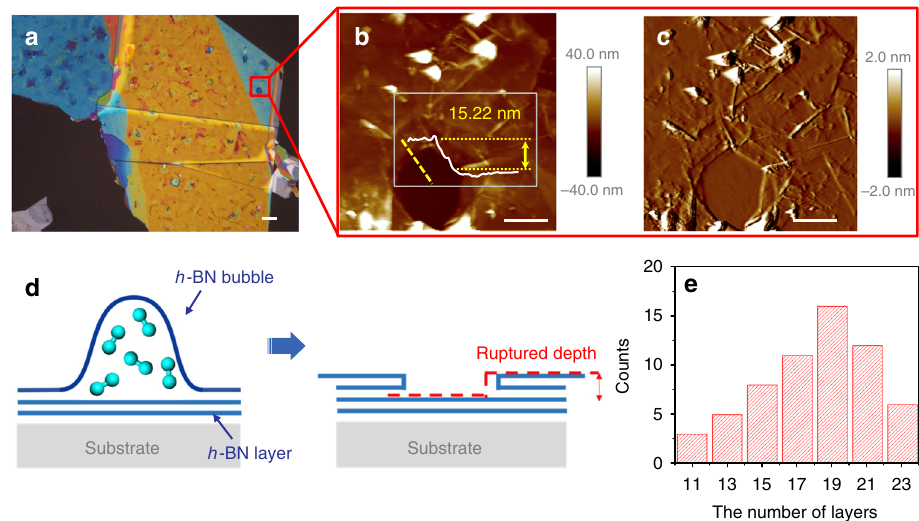
Fig. 5 Penetration depth of atomic hydrogen into h -BN multilayers. a Optical image of an h -BN fl ake on which the bubbles generated by a 400 W H-plasma treatment ruptured. h -BN fl aps peeled off the adhered macroscopic fi lms, and the multilayer h -BN sheets tore and then folded. b AFM height and c amplitude error images taken of the red area shown in ( a ). The bottom of the pit is atomically fl at, and no bubble fi lled with hydrogen molecules was found. The insert in ( b ) is the AFM depth pro fi le along the yellow dashed line. The deviation in the height is approximately 15.2 nm, indicating that ~23 atomic layers were ruptured and folded over the top layer of h -BN. The scale bars in ( a – c ) represent 1 μ m. d Illustration of the ruptured depth for the folding steps depicted in ( b , c ) caused by the bursting of the h -BN bubble. e Depth distribution of penetration into the surface of the h -BN fl ake shown in ( a )